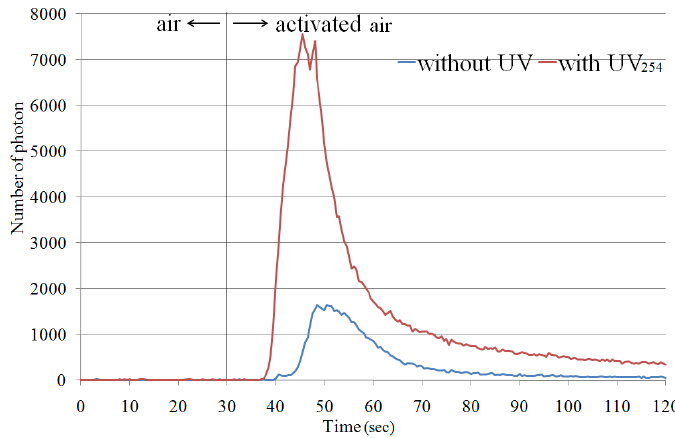
Fig. 12 Chemical luminescence from activated air microbubble with or without UV irradiation.